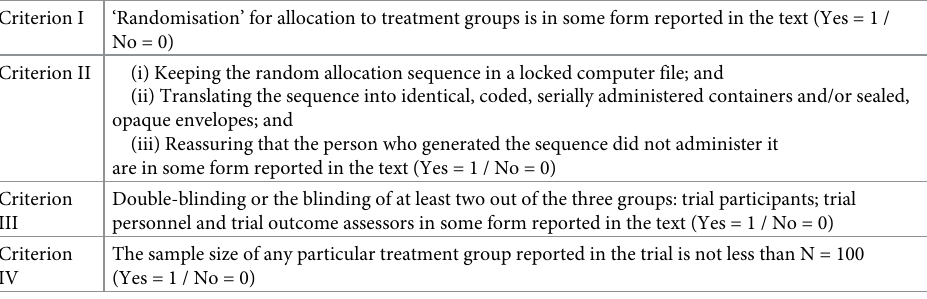
Table 2. Appraisal criteria of the extended Composite Quality Score